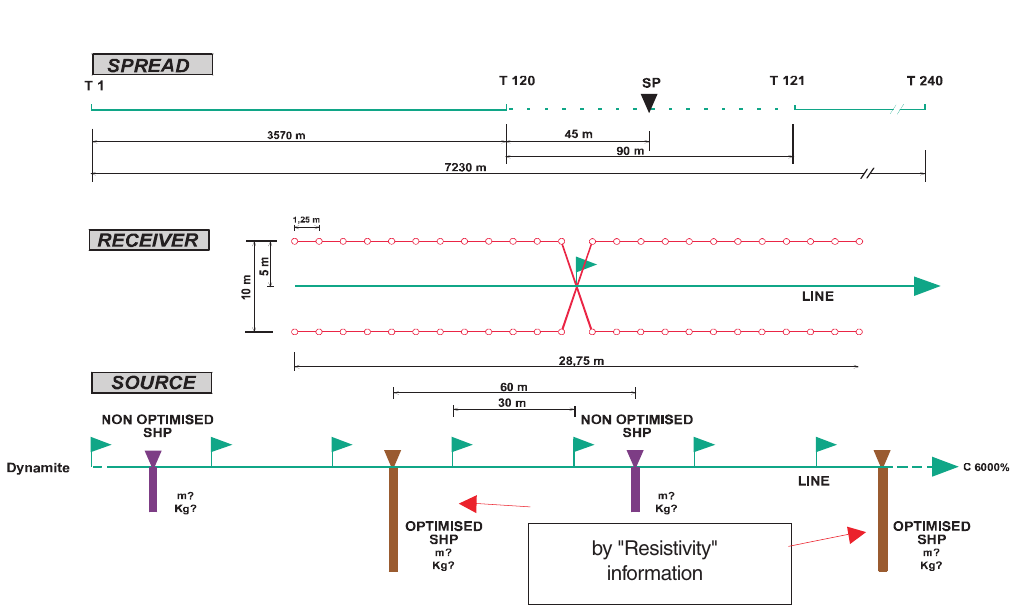
Fig. 5. Roll-along 2D near vertical seismic recording